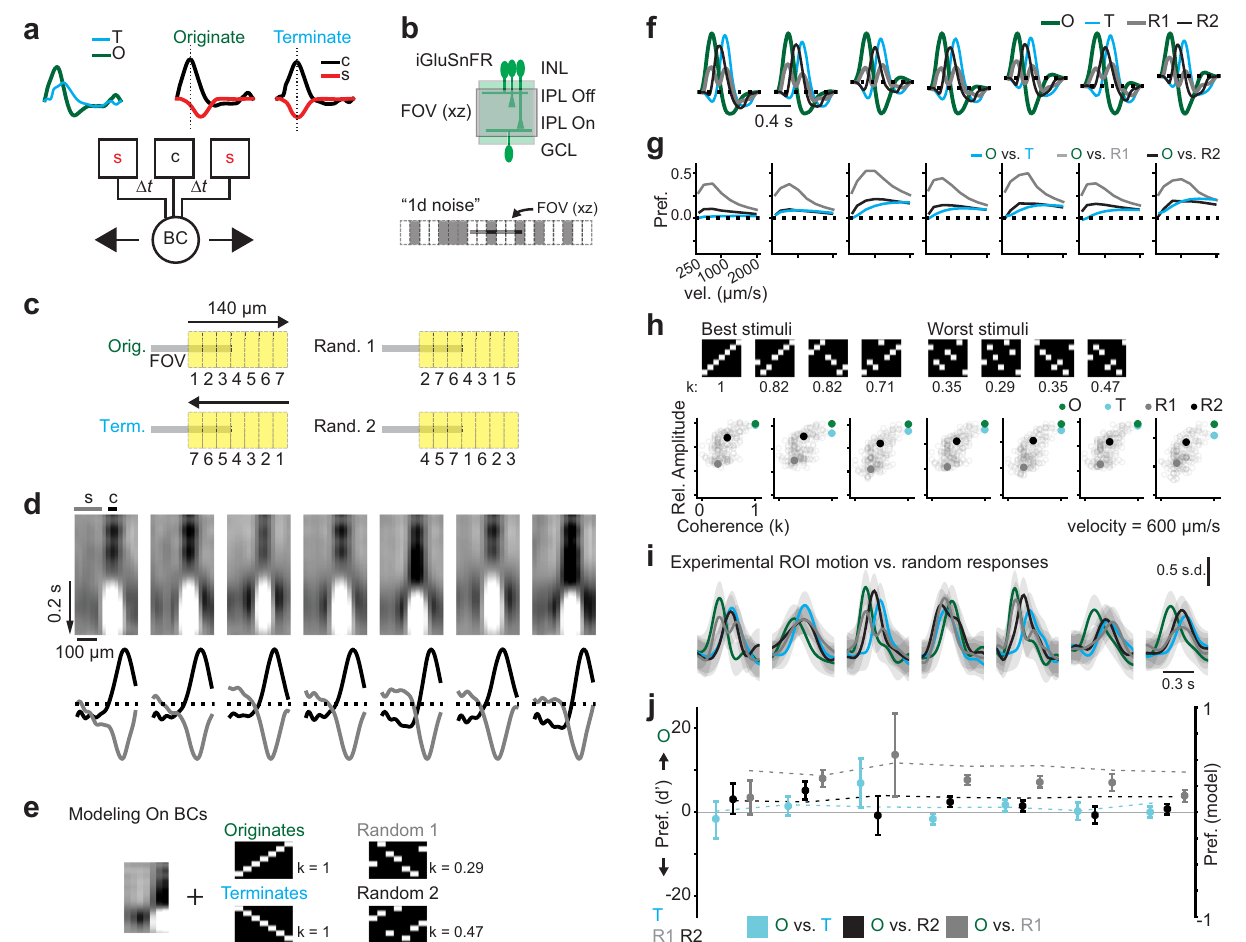
Fig.4|Bipolarcellsprefermotiontonon-motionstimuli.a Modeledresponseof one BC cluster (see Supplementary Fig. 10) to outward and inward motion. Responses were decomposed into BC RF center ( c , black) and surround (s, red) contributions (Supplementary Fig. 7). These coincide during inward motion, lead- ing to a smaller activation according to a Barlow-Levick detector (bottom) 53 . Δ t, temporal offset. b iGluSnFR imaging and “ 1D noise ” stimulus to assign cluster membership and predict motion responses. c Stimuli used to assess stimulus preference, by presenting seven 20×50 μ m rectangles in sequences to create apparentoriginating( “ Orig. ” ),terminating( “ Term. ” )motion,oroneoftworandom ( “ Rand. ” ) sequences. Apparent velocity, 600 μ m/s. d Top: average RF of each cluster. “ c ” and “ s ” show the regions used to calculate the spatial average of the center and surround below. Bottom: average temporal RFs taken from “ c ” and “ s ” regions indicated in ( d ), normalized to their respective peaks. Sample size is 5837 ROIs/5 fi elds/3mice. e ExampleRFconvolvedwiththemotionandrandomstimuli